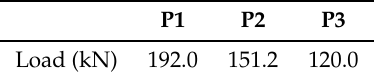
Table 3. Applied mechanical